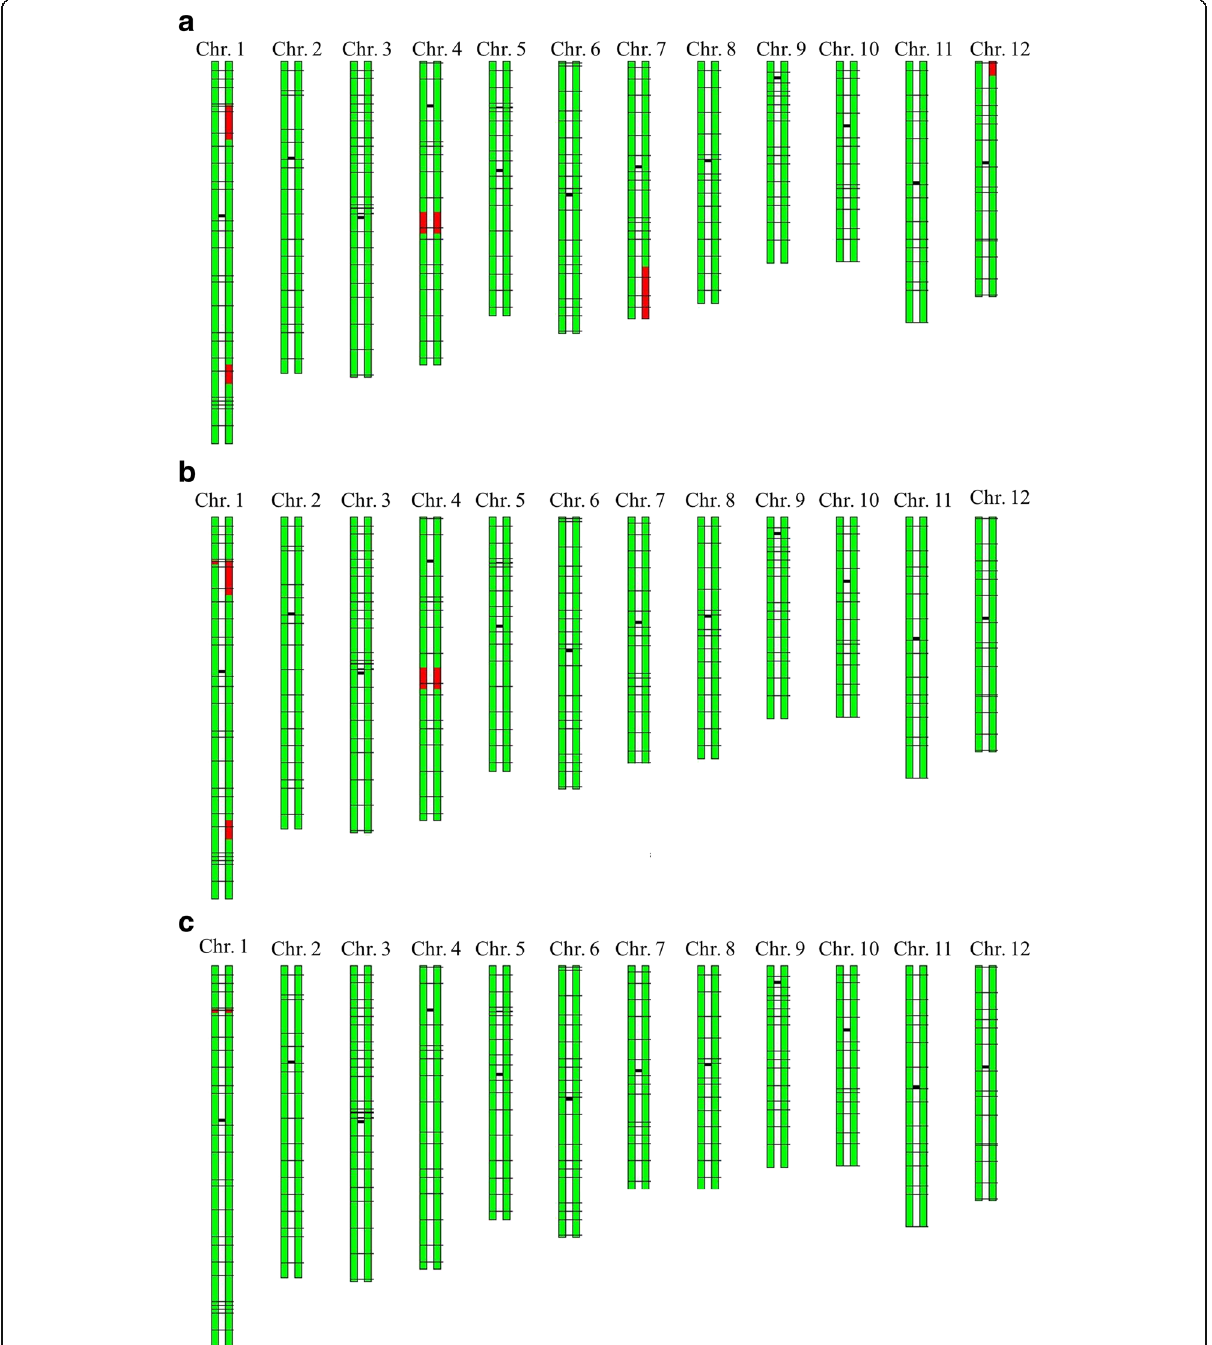
Fig. 5 GGT of the selected lines. a BC 3 F 2 -2B09. b BC 3 F 3 -652E09. c BC 4 F 2 -350C05. The green bars represent the chromosome fragments derived from Kongyu 131, the red bars represent the chromosome fragments derived from GKBR, and the horizontal black lines indicate the SNP markers(the shorter, darker lines represent the